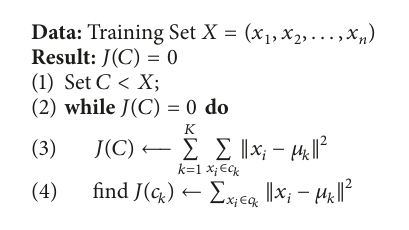
Algorithm1: 𝐾 -meansalgorithminthestrokedatasetand2DmBd stroke datasets.